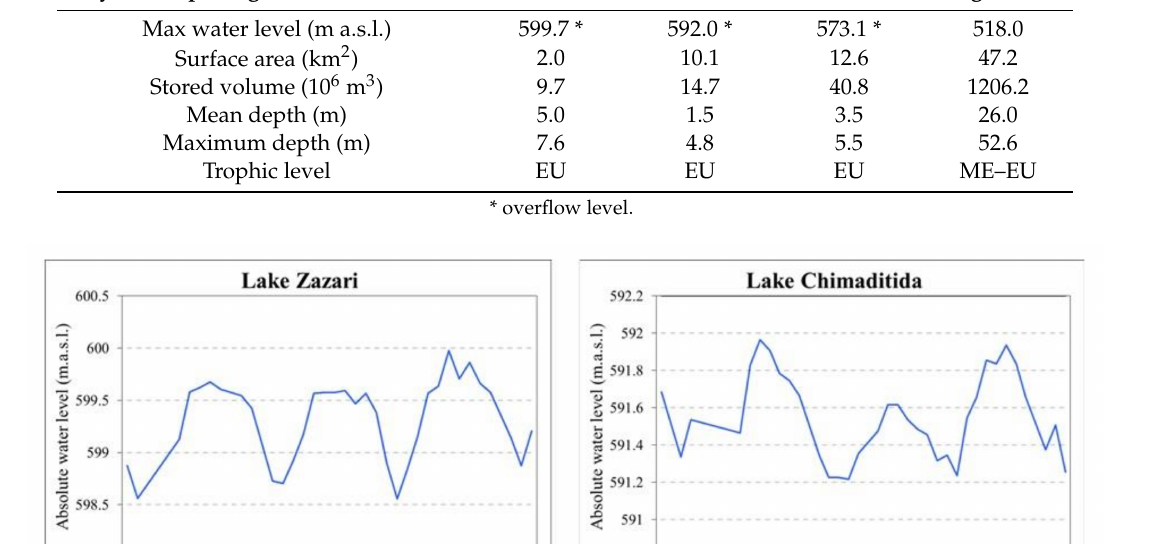
Table 1. Hydromorphological characteristics of the four studied lakes. EU—eutrophic; ME—mesotrophic. Hydromorphological Characteristics